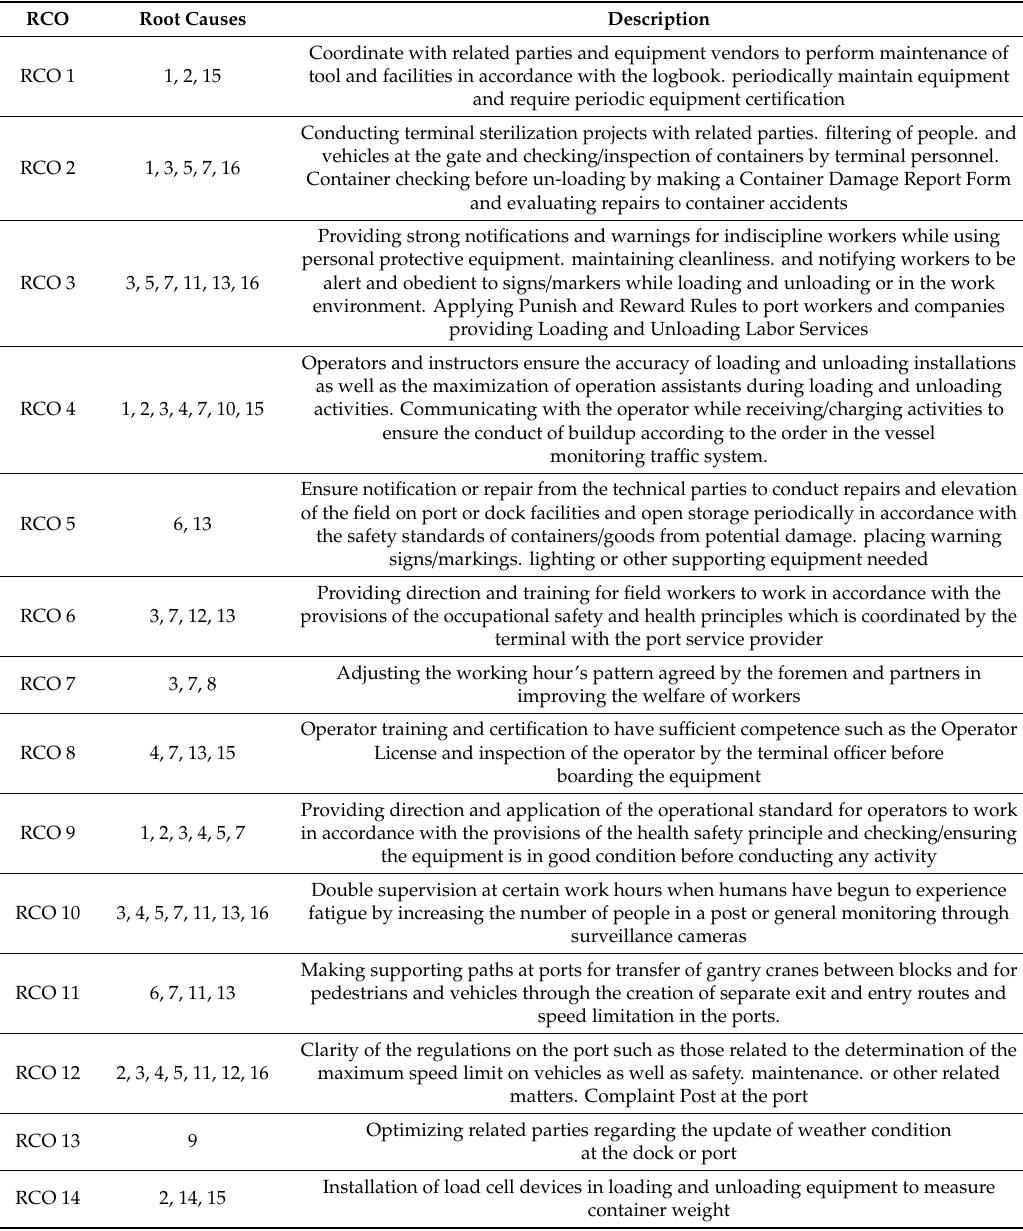
Table 13. Risk Control Options